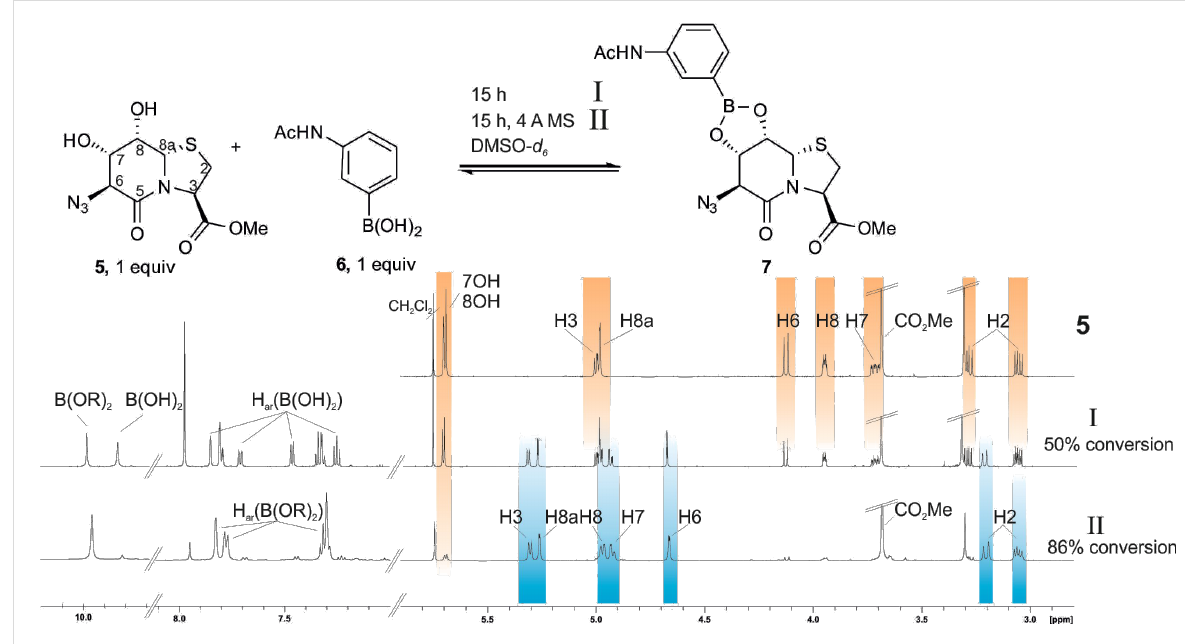
Figure 4: Diol 5 (6.08 mg, 20.0 μ mol, 1.0 equiv) and 3-(acetylamino)phenylboronic acid ( 6 , 3.56 mg, 20.0 μ mol, 1.0 equiv) form ester 7 in an NMR experiment in DMSO- d 6 . The 1 H NMR spectrum shows an esterification of 58% (2.5 equiv H 2 O). Molecular sieves which adsorb water out of the equi- librium push the equilibrium to 86% (1.0 equiv H 2 O) conversion.